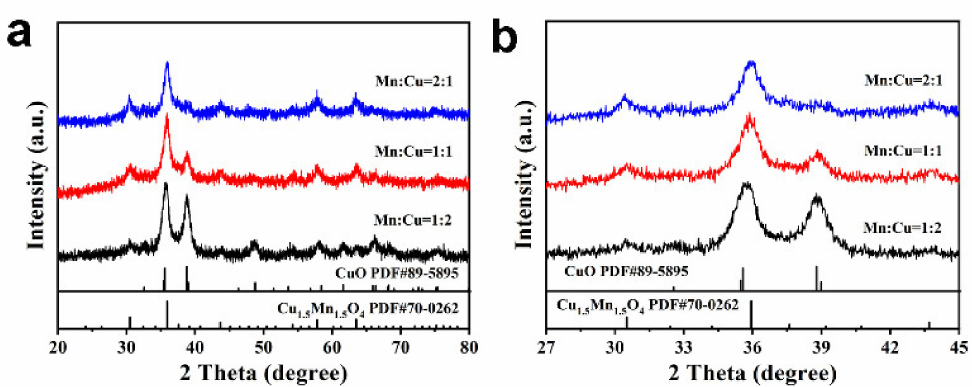
Figure 1. ( a ) The powder XRD patterns of CuO x /Cu 1.5 Mn 1.5 O 4 ; ( b ) partially enlarged